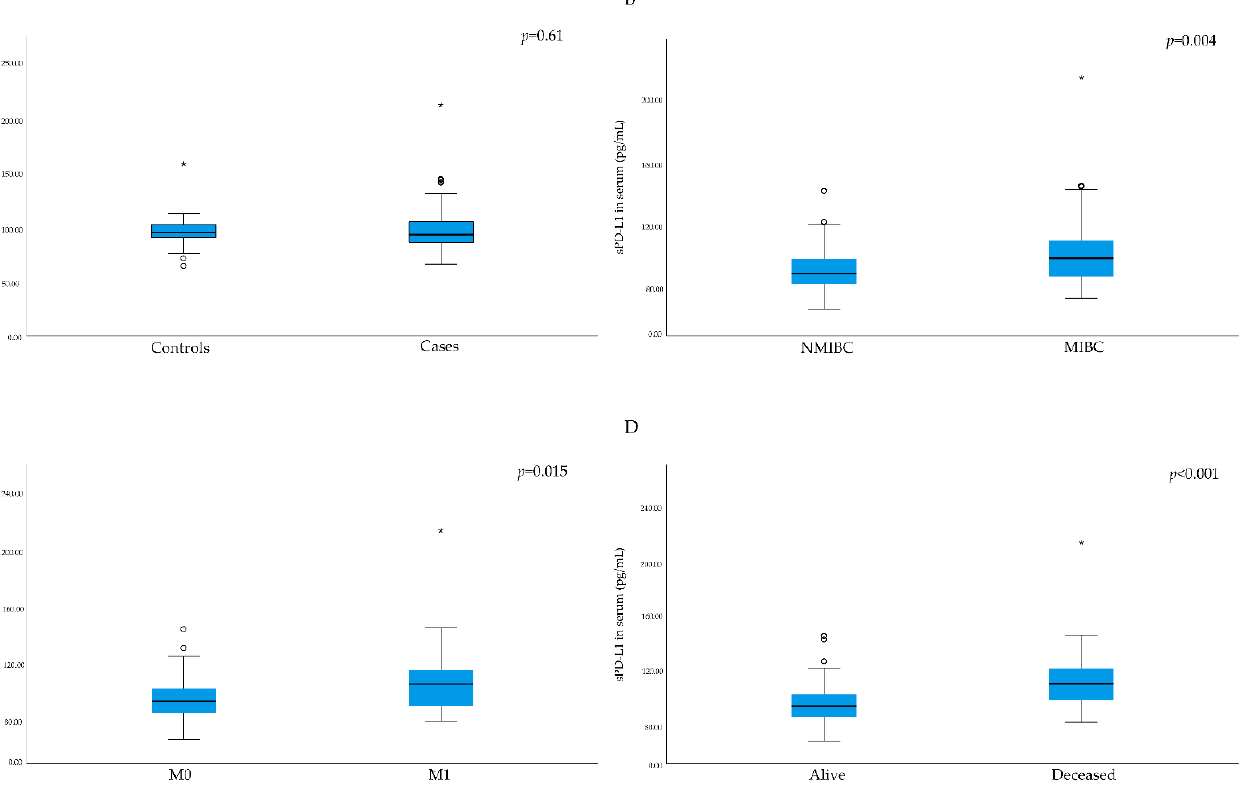
Figure 1. Box plots of serum levels of soluble programmed death ligand 1 (sPD-L1). ( A ) Across controls and cases. ( B ) Patients with non-muscular invasive disease (NMIBC) versus patients with muscular invasive disease (MIBC). ( C ) Patients with (M1) or without distant metastases (M0). ( D ) Patients who died during follow-up vs. patients who survived during the follow-up time. Outliers in the data are represented by a circle ( ◦ ), and extreme outliers are represented by an asterisk (*).